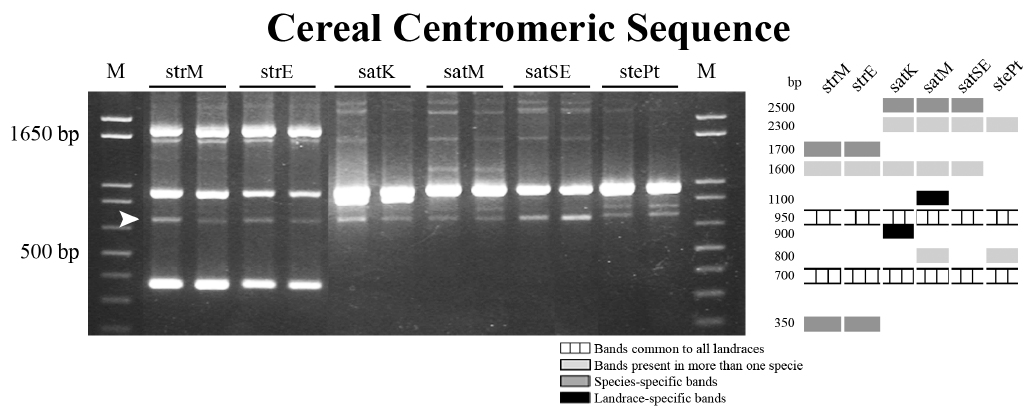
Figure 4. PCR amplification products obtained using CCS1 primers and correspondent schematic representation. M: molecular marker 1 Kb+; strM— A. strigosa from Madeira Island; strE— A. strigosa from Elvas; satK— A. sativa “Kyto”; satM— A. sativa from Madeira Island; satSE— A. sativa “S. Eulália”; stePt— A. sterilis Pt. Arrowhead indicates the Avena characteristic band that was amplified from all genotypes, isolated and sequenced.